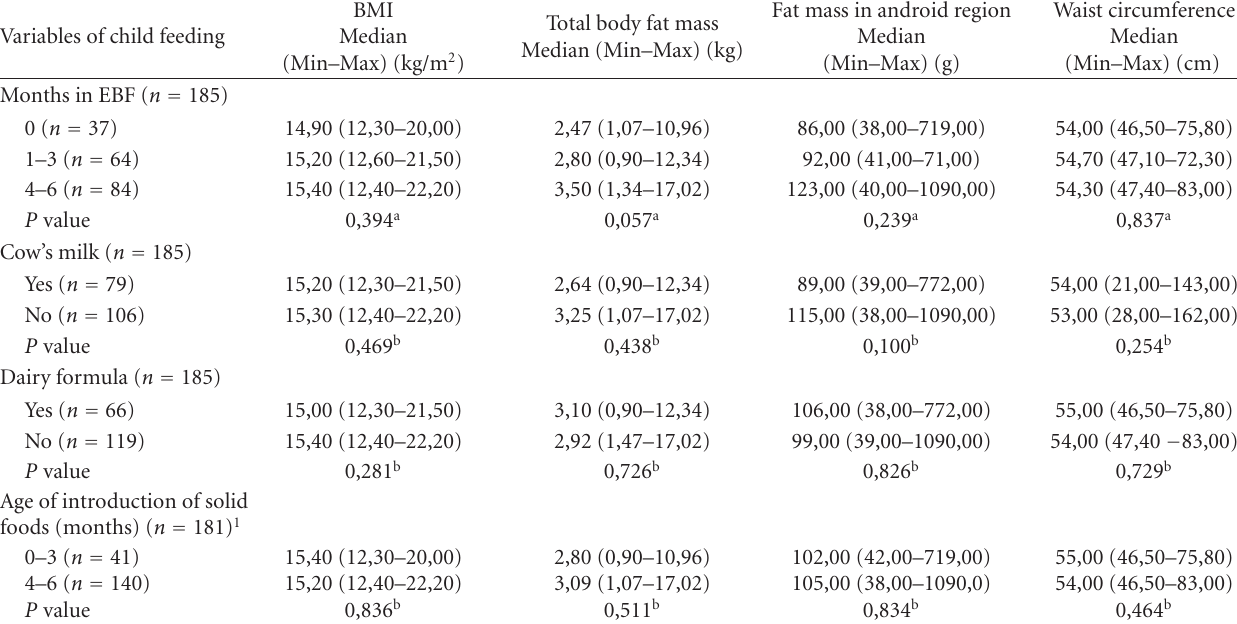
Table 1: Comparison of BMI, total body fat mass in the android region and waist circumference according to di ff erent practices of exclusive breastfeeding and consumption of other foods in the first 6 months of life of children from 4 to 7 years, Vic¸osa, MG, Brazil 2010/11. Variables of child